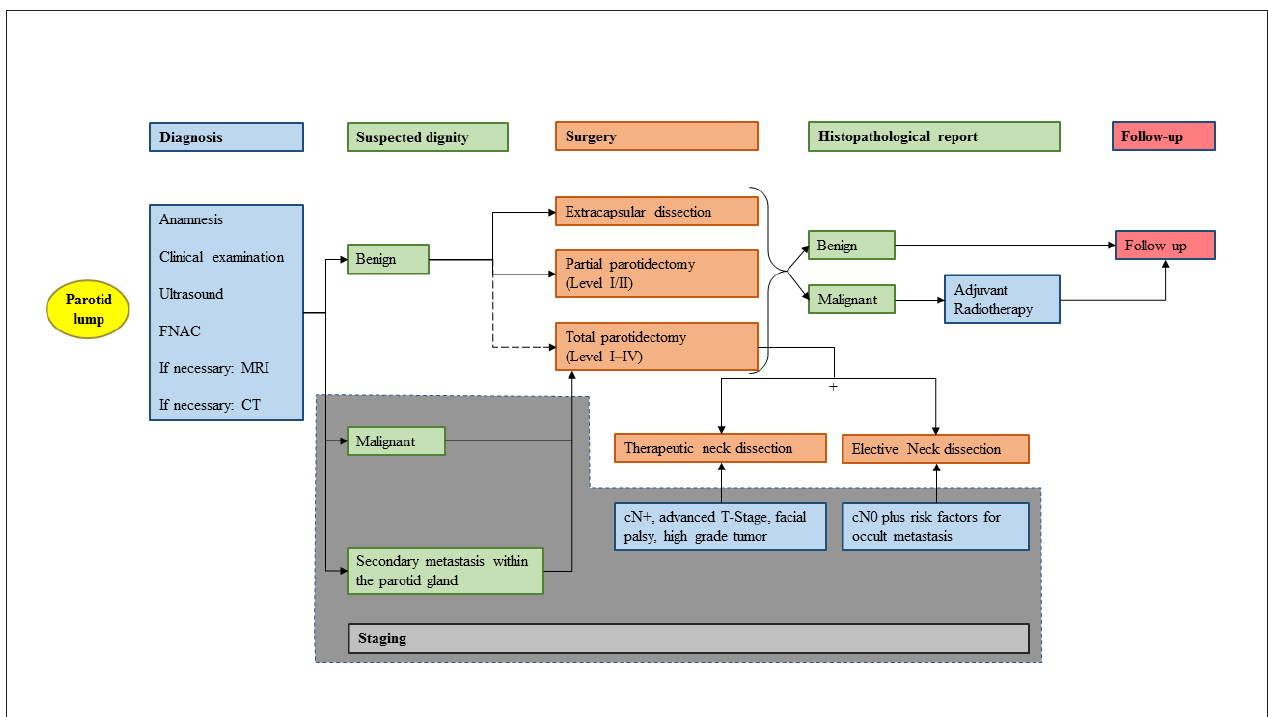
FiGuRe 1 | Treatment algorithm. Simplified representation of the treatment of a primary and resectable parotid lump from initial presentation, examination, diagnostics, surgery, adjuvant treatment, ending with the follow-up. This algorithm summarizes data from the studies cited in the article (mainly studies with only moderate evidence) and includes the personal experience of the authors. FNAC, fine needle aspiration cytology; MRI, magnetic resonance imaging; CT, computed